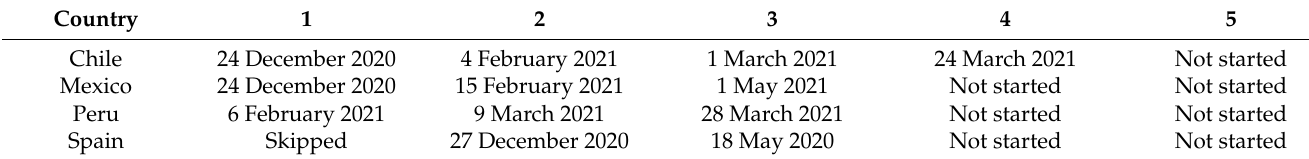
Table 1. Vaccination policy—values description. Value Target Groups 0 No availability 1 Key workers, clinically vulnerable groups, elderly groups (just one) 2 3 4